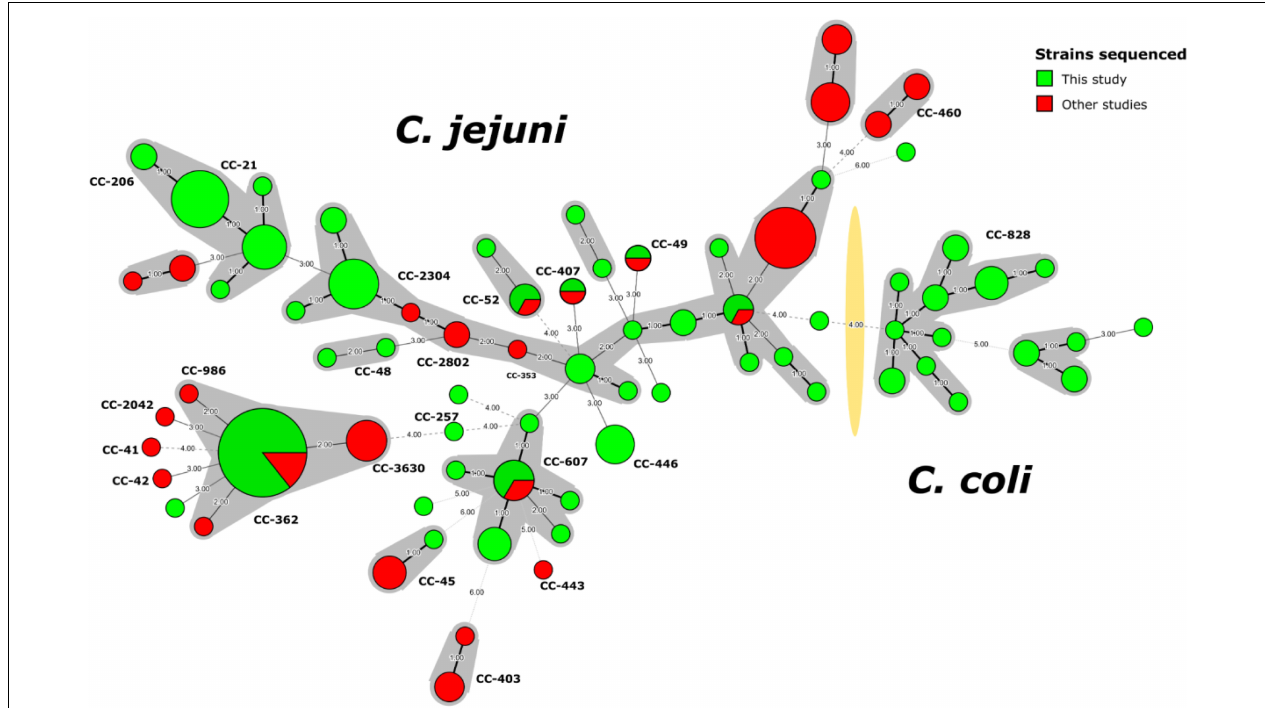
FIGURE 1 | Minimum spanning tree of C. jejuni and C. coli strains sequenced in Peru. The nodes indicate the detected genotypes (STs) and are proportional to the number of strains. Clonal complexes (CC) are indicated with shadows around the corresponding nodes and with bold letters closed to the nodes. The yellow shadow divided Campylobacter spp. into C. jejuni and C. coli . Strains from this study ( n = 129) are marked in green, while strains from other studies ( n = 62) are indicated in